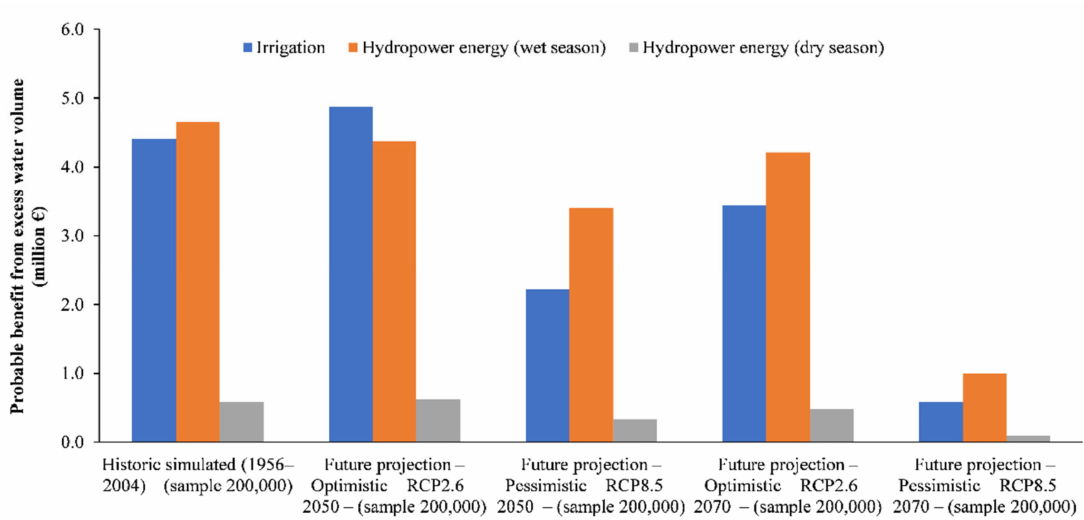
Figure 9. Irrigation benefit (in million € ) together with the hydropower benefit (in million € ) for the wet (November to April) and dry (May to October) months, for the current period and for the near and far